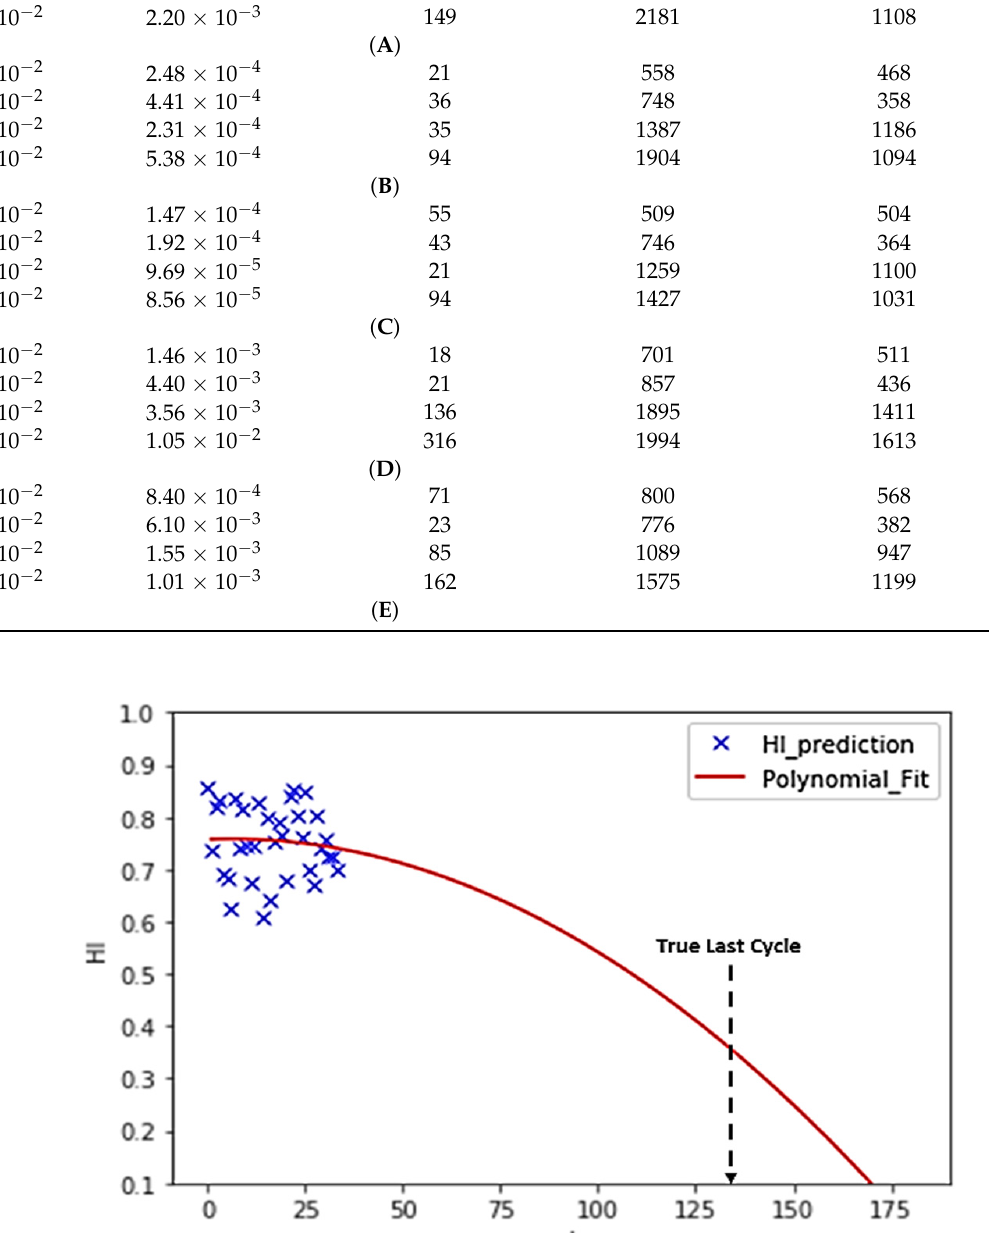
Figure 14. FD001_Test turbo unit 84 (172 cycles) test data validation.